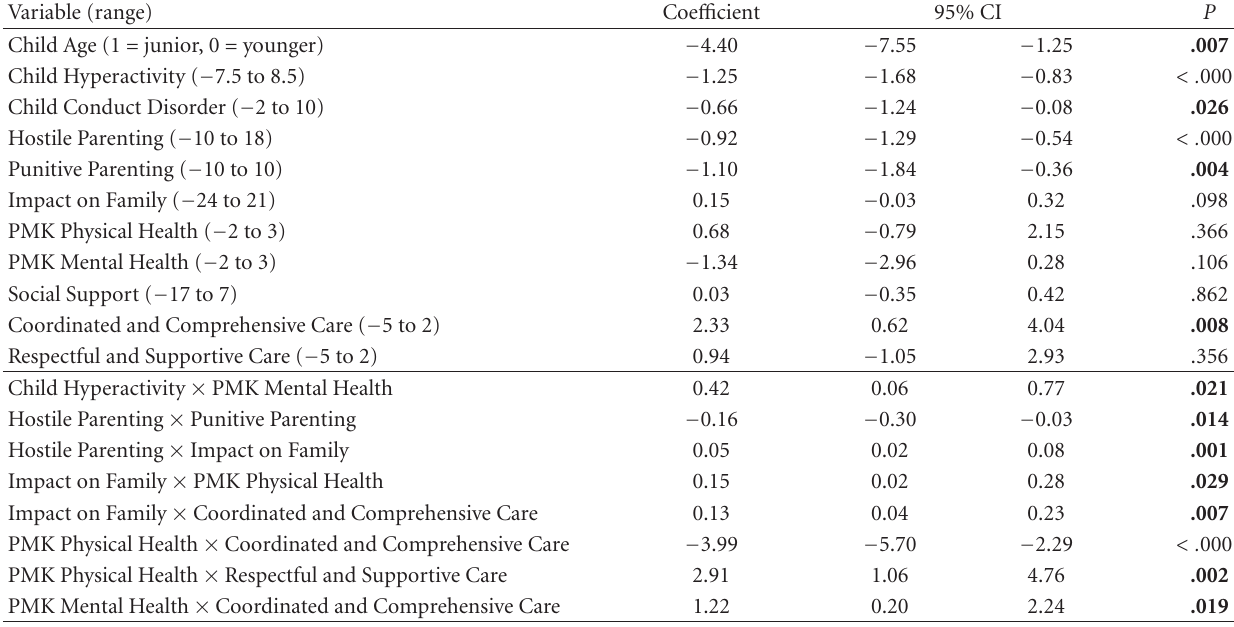
Table 4: Regression analysis